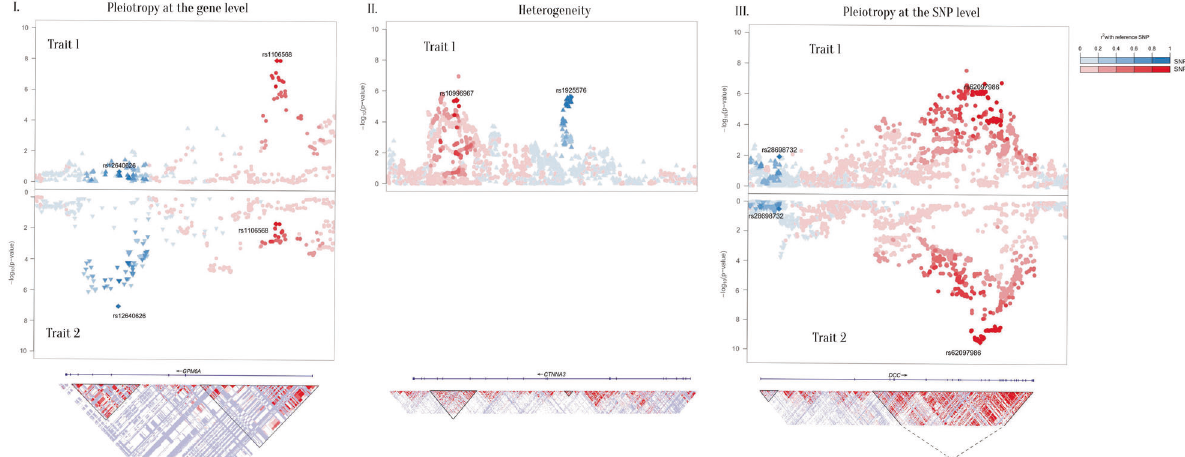
Fig. 1 Three possible scenarios for genes harbouring multiple association signals. Upper panels: regional association plots illustrating the three different scenarios. Scenario I, Pleiotropy at the gene level: two LD-independent clusters within the gene GPM6A are associated with SCZ (red cluster, trait 1) and education (blue cluster, trait 2). Scenario II, Allelic heterogeneity: within one gene ( CTNNA3 ), two LD-independent clusters are associated with one trait (Education). Scenario III, Pleiotropy at the SNP level: within the gene DCC , one cluster of LD-dependent genetic variants is associated with both depression (trait 1) and putamen volume (trait 2). Red and blue colours correspond to the strength of LD with the fi rst and second tagged SNPs. Figures were plotted using the LocusZoom tool [90]. Lower panels: underlying LD pattern for each region. Figures were obtained using the UCSC Genome Browser [56] with CEU population as reference and LOD values